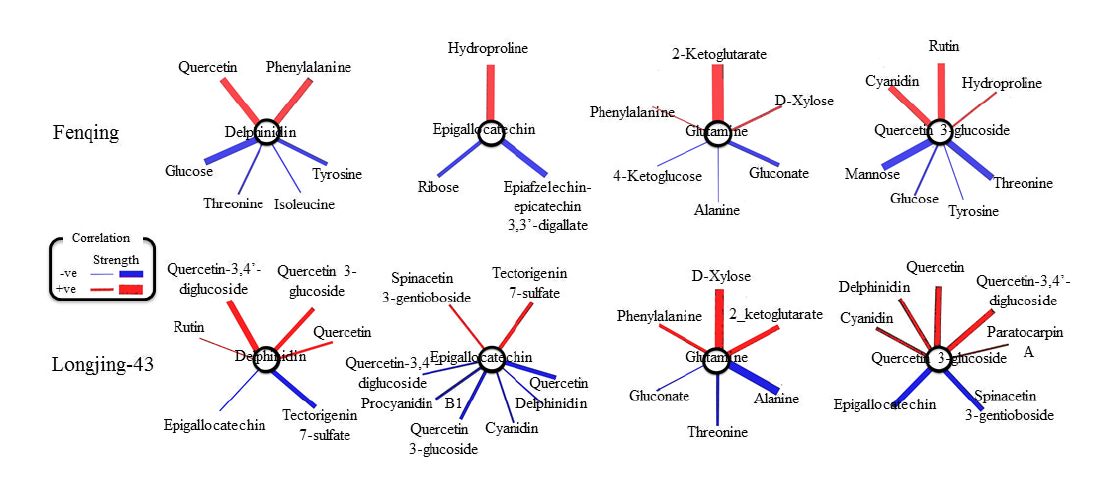
Figure 3. Correlations between fold change (log 2[ − P/+P] ) of selected significantly changed ( p < 0.05, t -test) metabolites in young shoots of Fengqing and Longjing-43. Red and blue colors indicate positive and negative coefficients and line thickness indicate correlation